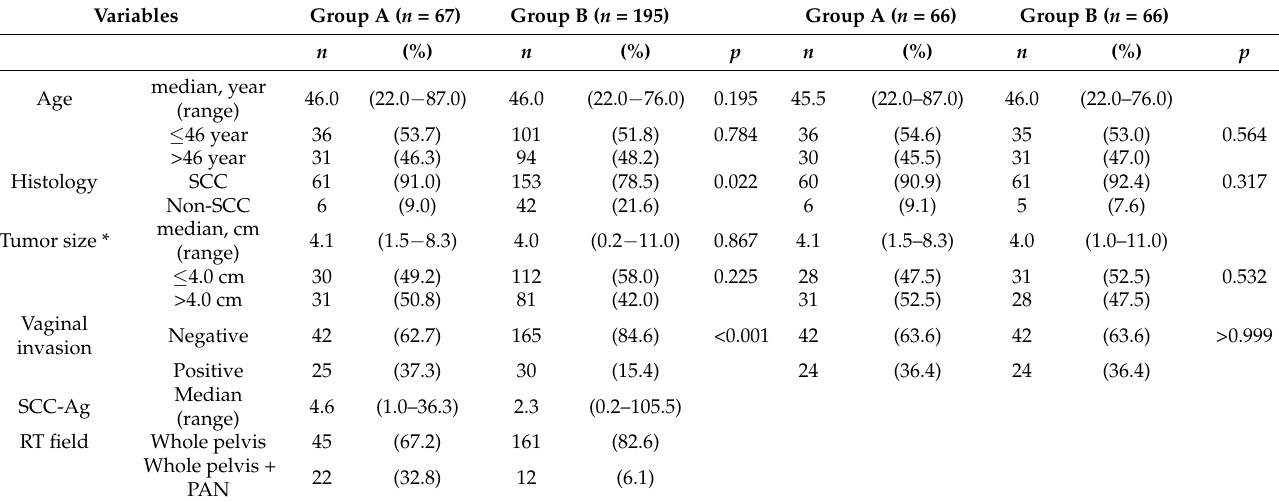
Table 1. Patient characteristics before and after one-to-one propensity score